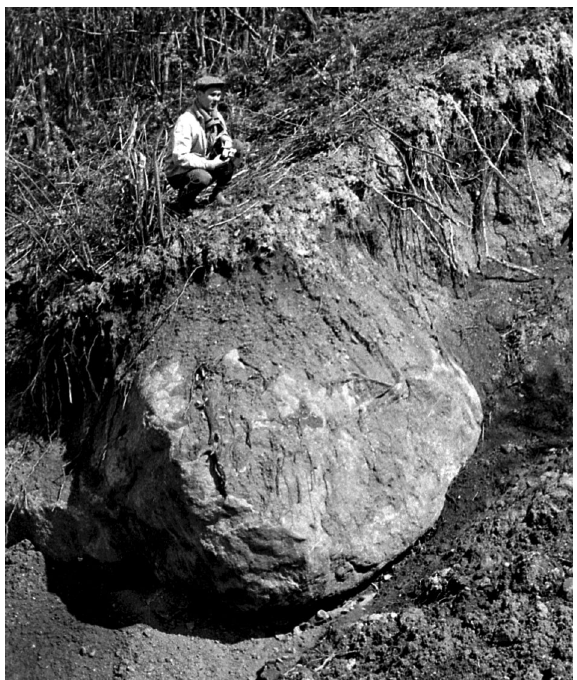
Fig. 11. A large boulder in the distal part of Tornim(cid:228)gi Hill. Photo by A. Raukas.